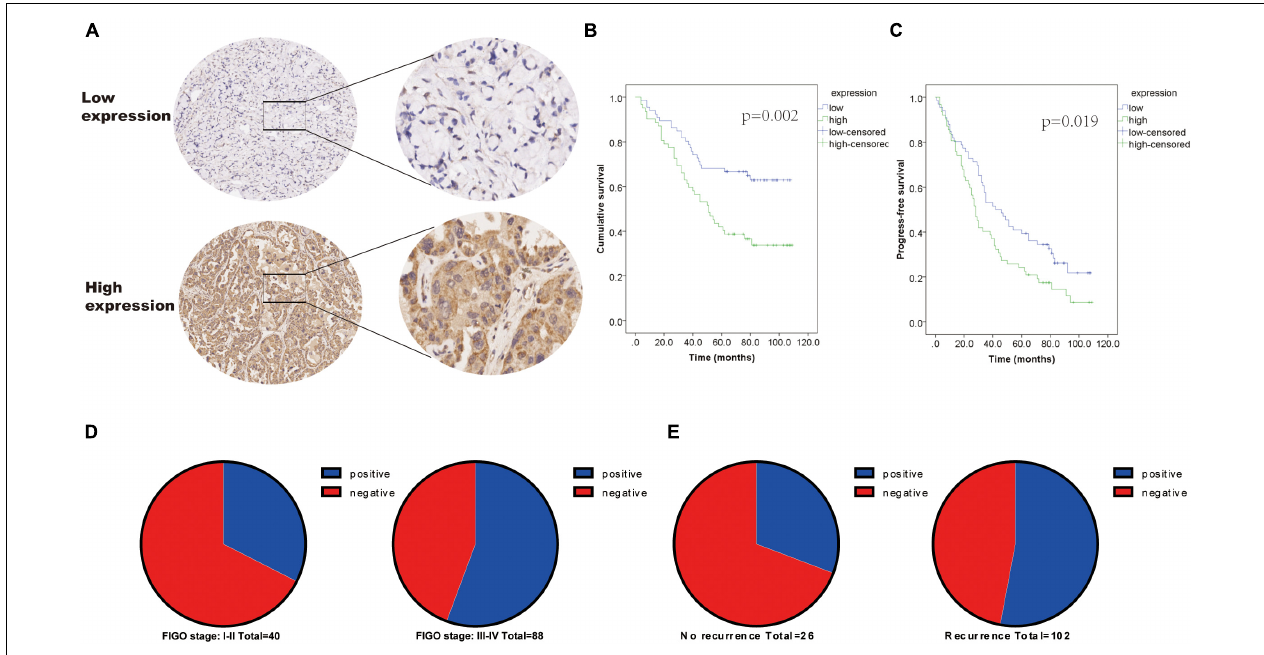
FIGURE 1 | Positivity expression of MAVS is associated with advanced clinical factors and poor survival of OC patients. (A) Representative images of IHC staining of MAVS on tissue microarray of ovarian cancer specimens. (B) Overall survival (OS) of OC patients was analyzed by the Kaplan–Meier plotter analysis. (C) Progression-free survival (PFS) of OC patients was analyzed by the Kaplan–Meier plotter analysis. (D) MAVS expression in different clinical stages of OC was detected by IHC analysis. (E) MAVS expression OC patients with different status of recurrence was detected by IHC